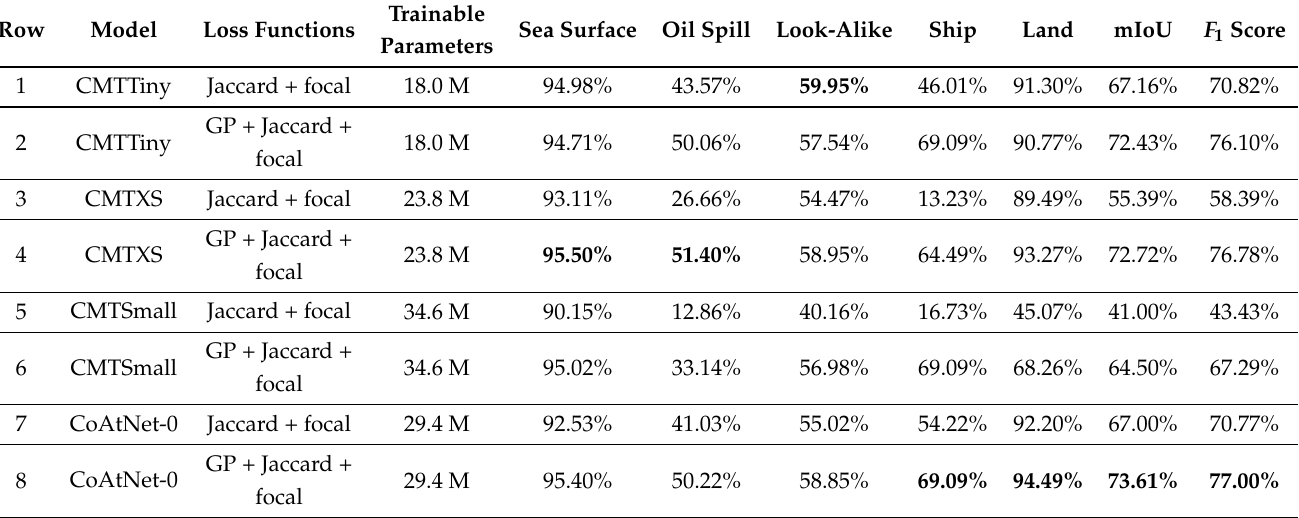
Table 5. Ablation on different CNNs and ViTs-based hybrid models and different loss functions, evaluated over the test SAR images in terms of the IoU and F 1